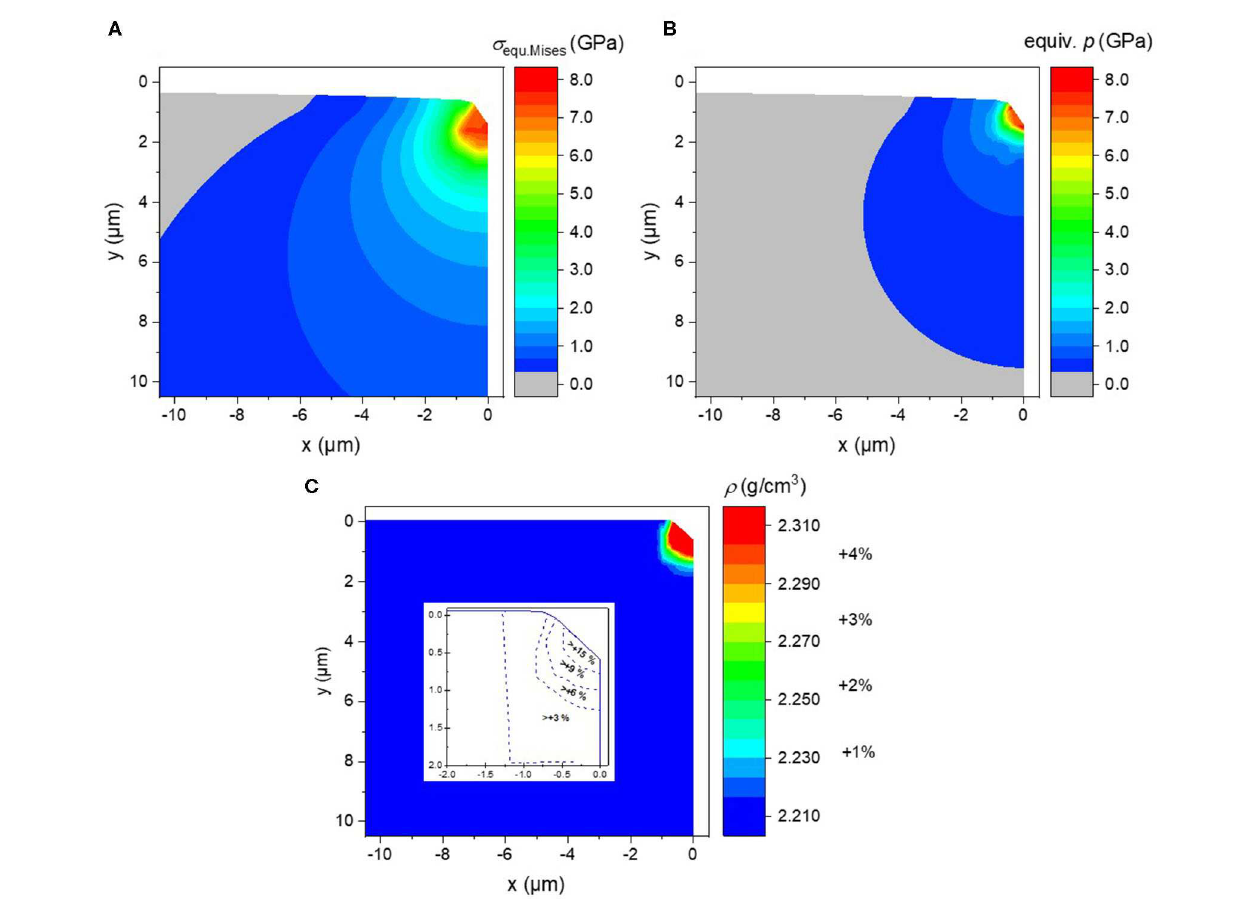
FIGURE 4 | FEA results of a wedge indentation experiment on vitreous silica in 2D representation. Indentation was performed to a similar penetration depth as in the SAXS-experiments. The contour plots show (A) the lateral distribution of the equivalent van Mises stress σ equMises, (B) the corresponding hydrostatic stress p and (C) the resulting density distribution ρ within the glass sample after unloading. The inset in (C) displays the densification in the vicinity of the indenter tip calculated using FEA data and the density of pristine vitreous silica, i.e., ρ (v-SiO 2 ) = 2.21 gcm − 3 . In all plots, the y -direction depicts the depth relative to the sample surface and the x -direction represents the lateral distance relative to the loading axis [indent center is located at ( x,y ) = (0,0)].